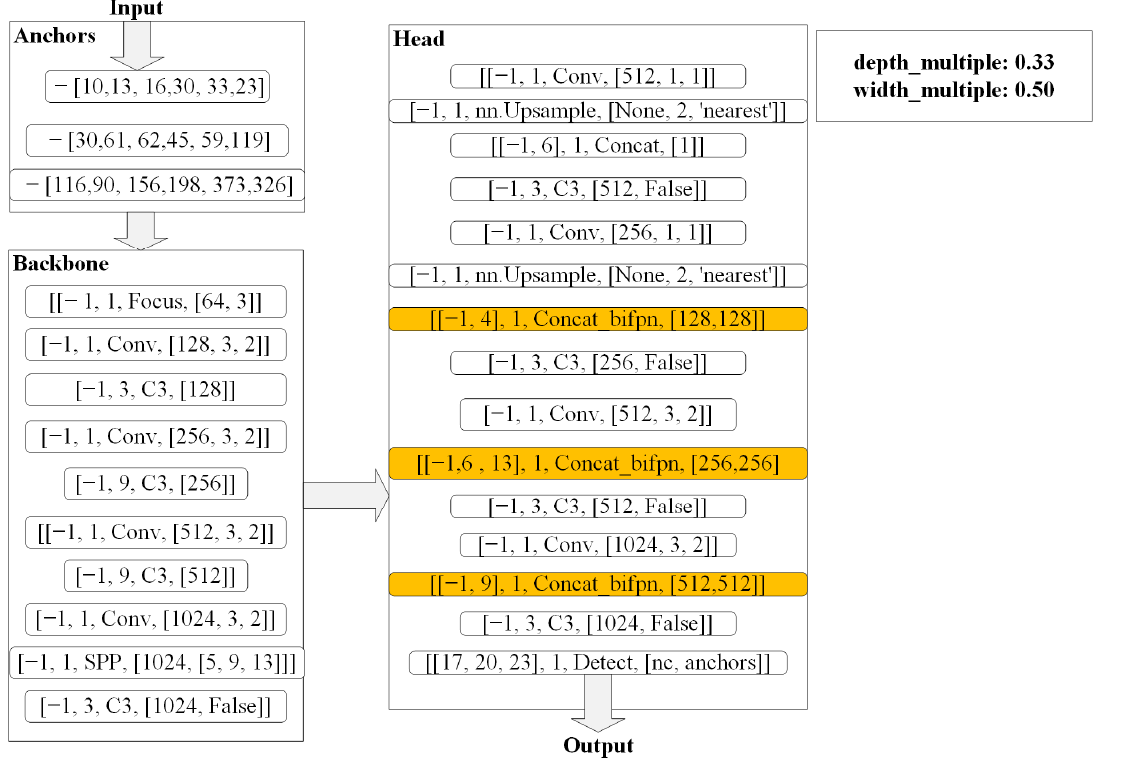
Figure 4. Feature extraction diagram of four types of pavement defects by BiFPN and PANet net- work structures. ( a ) lateral cracking, ( b ) longitudinal cracking, ( c ) alligator cracking, and ( d ) pothole. To enhance the transmission of image features of the deep learning model, we adopted the BiFPN network structure to strengthen the feature extraction ability of the deep learning network, compared with the original feature fusion network, PANet, as shown in Figure 3a, eliminating single-sided input nodes with less contribution to fusion. As shown in Figure 3b, the BiFPN network strengthens higher-level feature fusion in the processing path, processing each bidirectional path (top-down and bottom-up) as a fea- ture network layer, and repeats this process multiple times in the same layer. Through the fusion of weighted features, the importance of different input features is learned, and dif- ferentiated fusion is carried out for different features. BiFPN uses fast normalized fusion to fuse weighted features, which are defined as in Equation (1). The learning weight, wi, uses the ReLU activation function, with a value of ε = 0.0001, to strengthen the stability of the value. To further improve the detection efficiency of the deep network learning model,